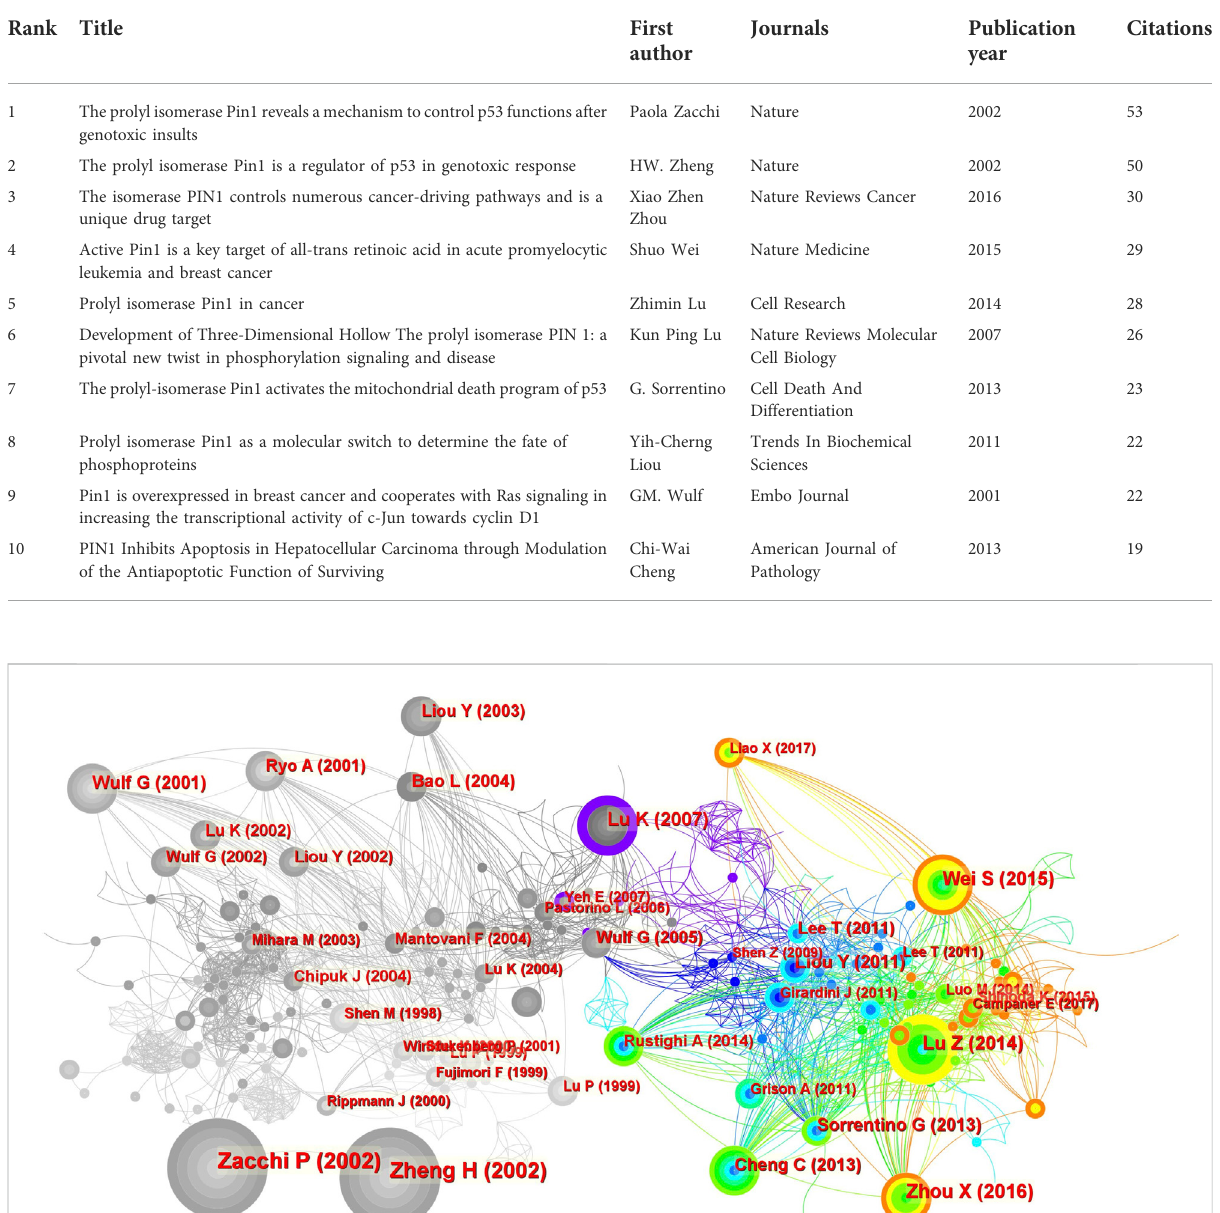
and England (0.20). In addition, the United States was the fi rst country to publish literature in this fi eld in 2001. All the above data show that the United States is the most in fl uential country in this fi eld. It is worth noting that China has the second-largest number of studies. Although centrality is low, the intensity of the literature explosion in China from 2017 to 2021 is as high as